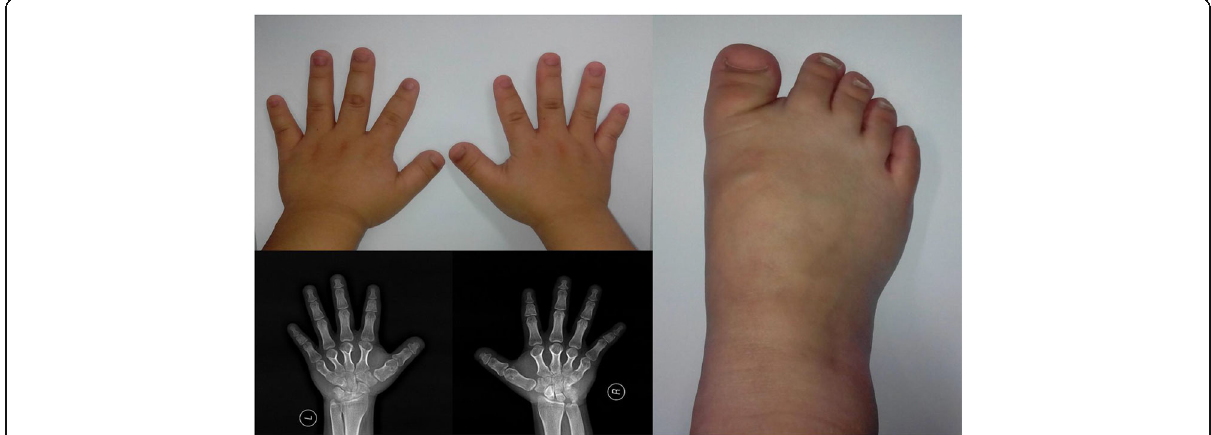
Fig. 1 Photos and radiographic images of the patient ’ s hands and right foot showing short fingers and toes associated with brachydactyly